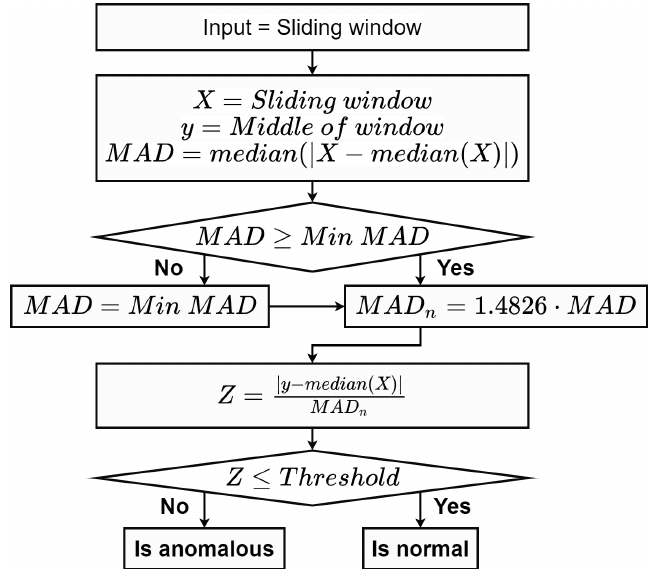
Figure 3. A flow chart of the median absolute deviation (MAD)